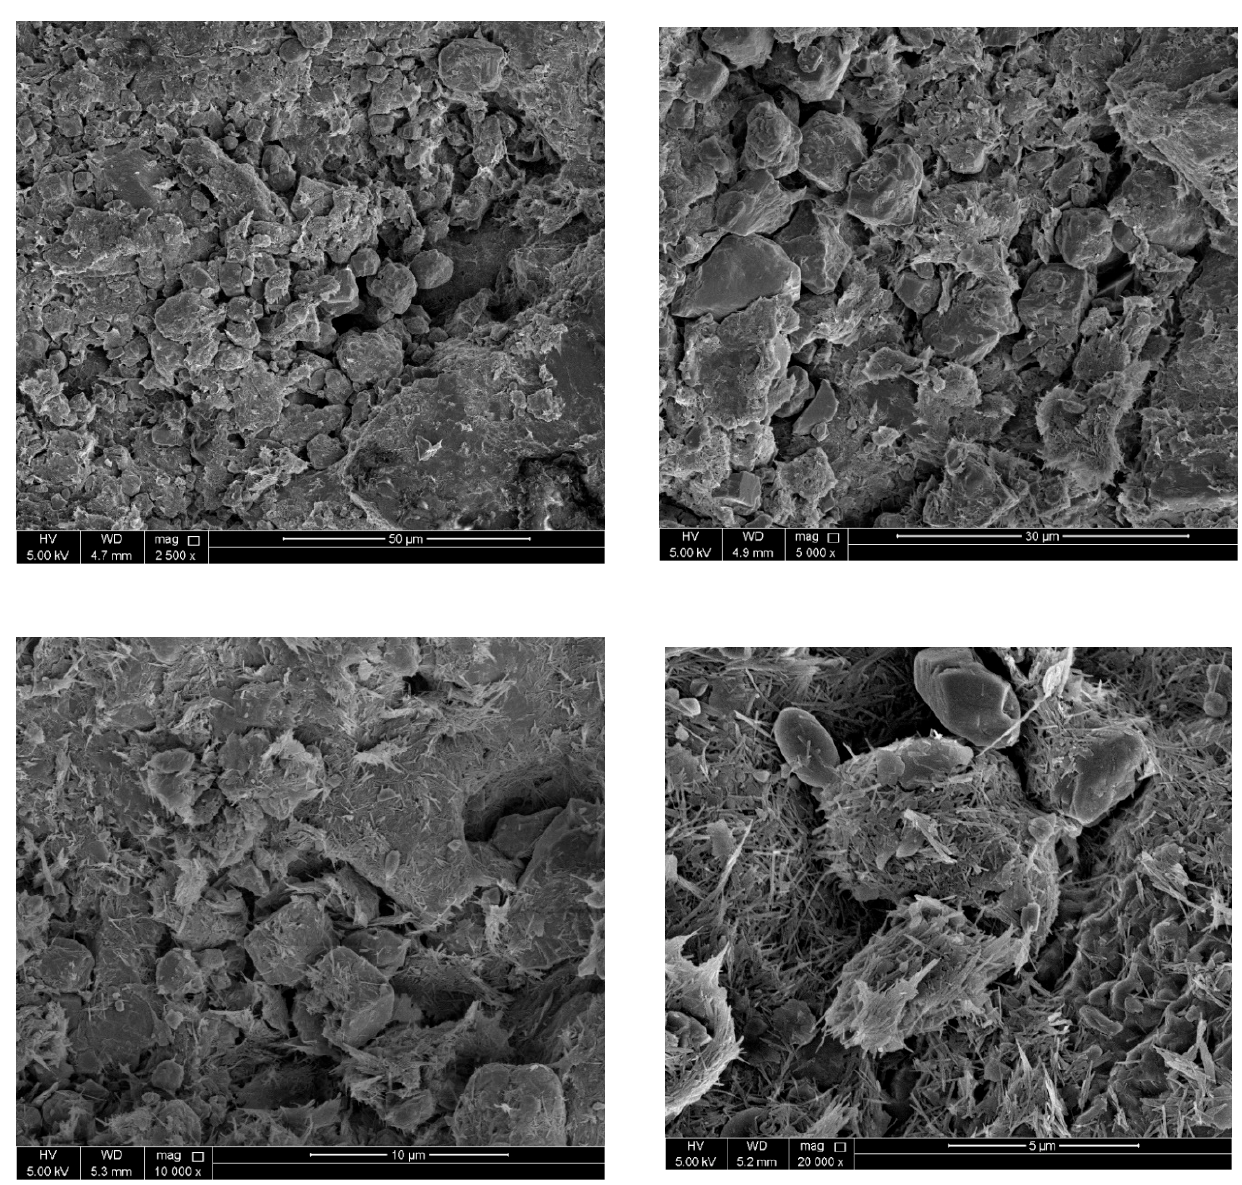
Figure 4. SEM images of TBM muck Sample #1 at different scales.